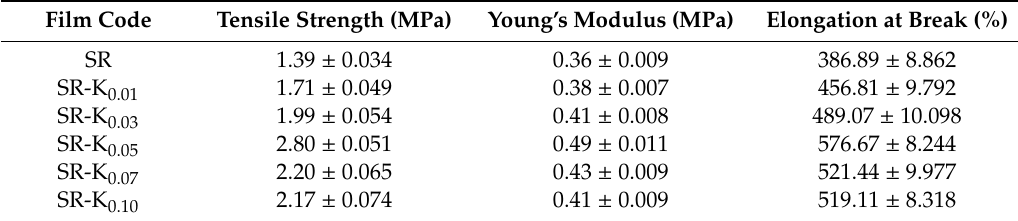
Figure 3. Effect of kaolinite content on the ( a ) tensile strength, ( b ) Young’s modulus, and ( c ) percent elongation at break. The mechanical performance increased gradually with the addition of kaolinite up to 5% ( w / w ). After that there was a decline in the performance due to the agglomeration and phase separation of kaolinite from the SR matrix. ( d ) Stress vs. percent elongation curves. Table 2. Summary of investigated mechanical properties of SR and NCPs.